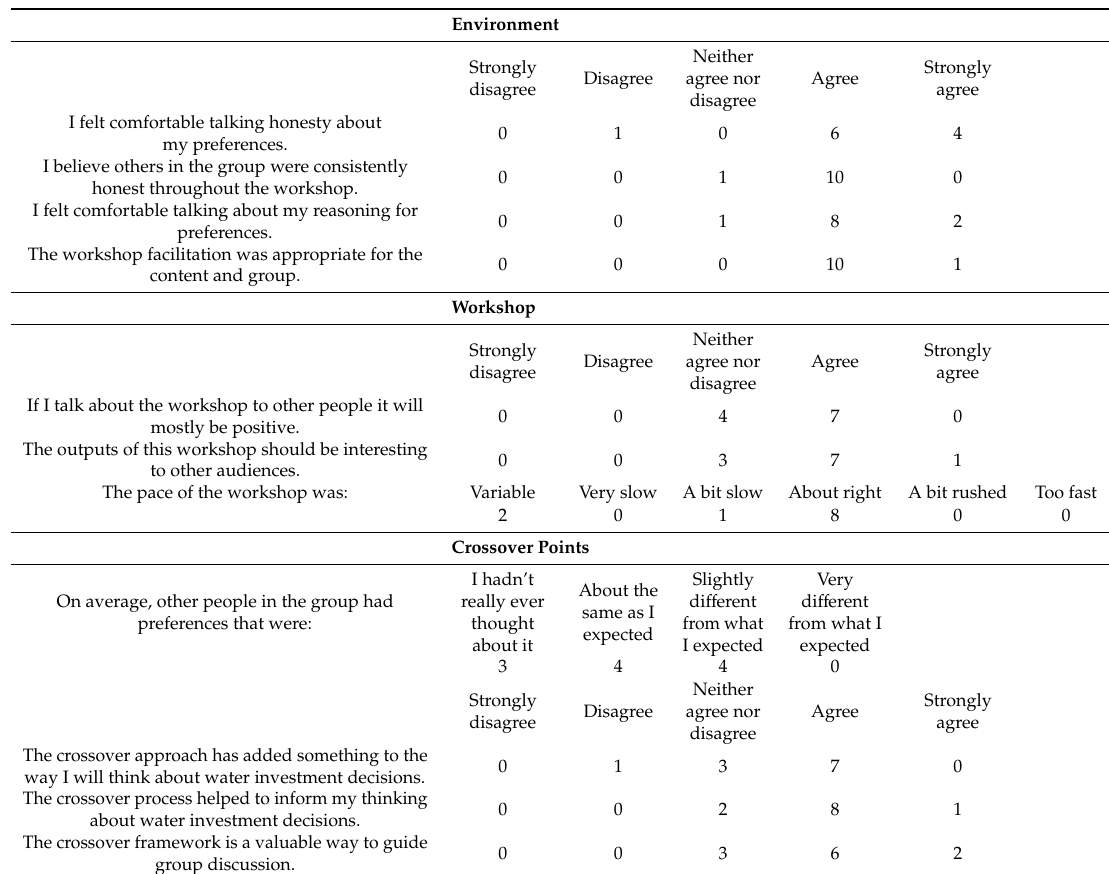
Table A1. Results from the evaluation immediately after the